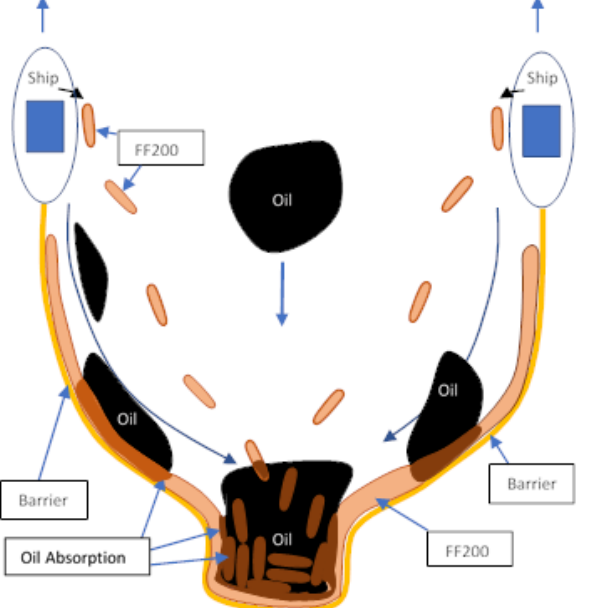
Figure 7. Schematic design of an example of combination between standard barrier and RMPUF, operating in open sea.